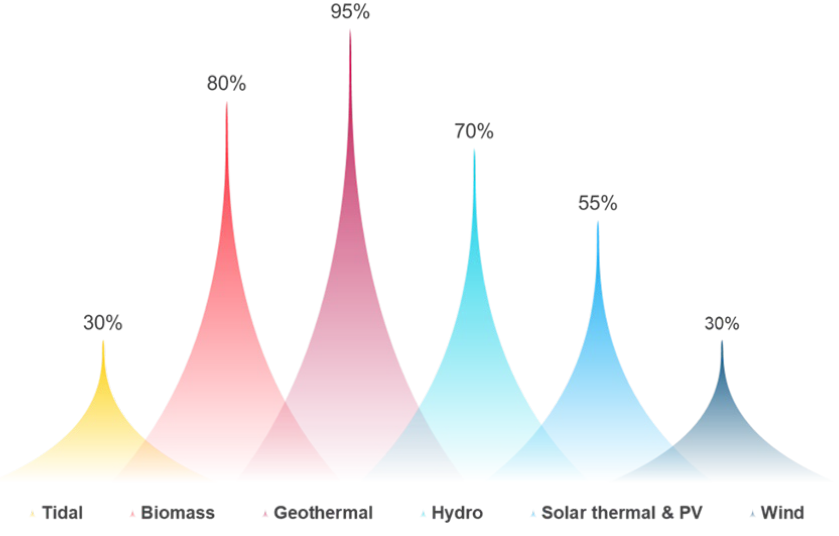
Figure 6. Reported capacity factor ranges (%) for several renewable sources.